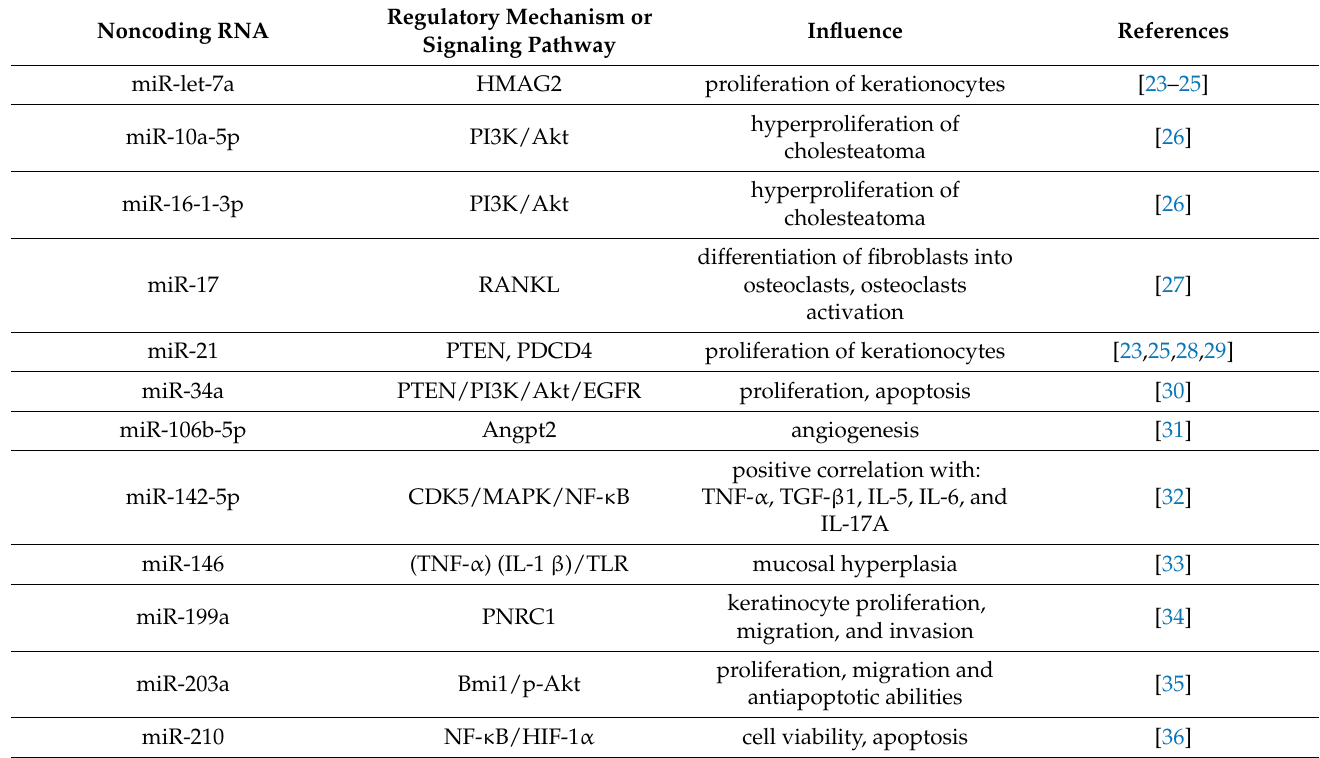
Table 2. Selected noncoding RNAs and their potential role in AOM, rAOM, COME and cholesteatoma. Noncoding